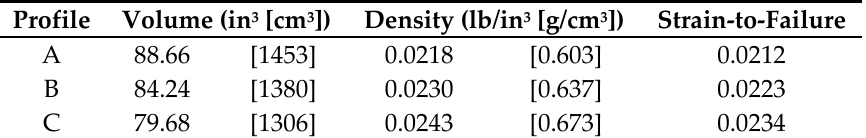
Table 3. Volume and density of bat profiles.